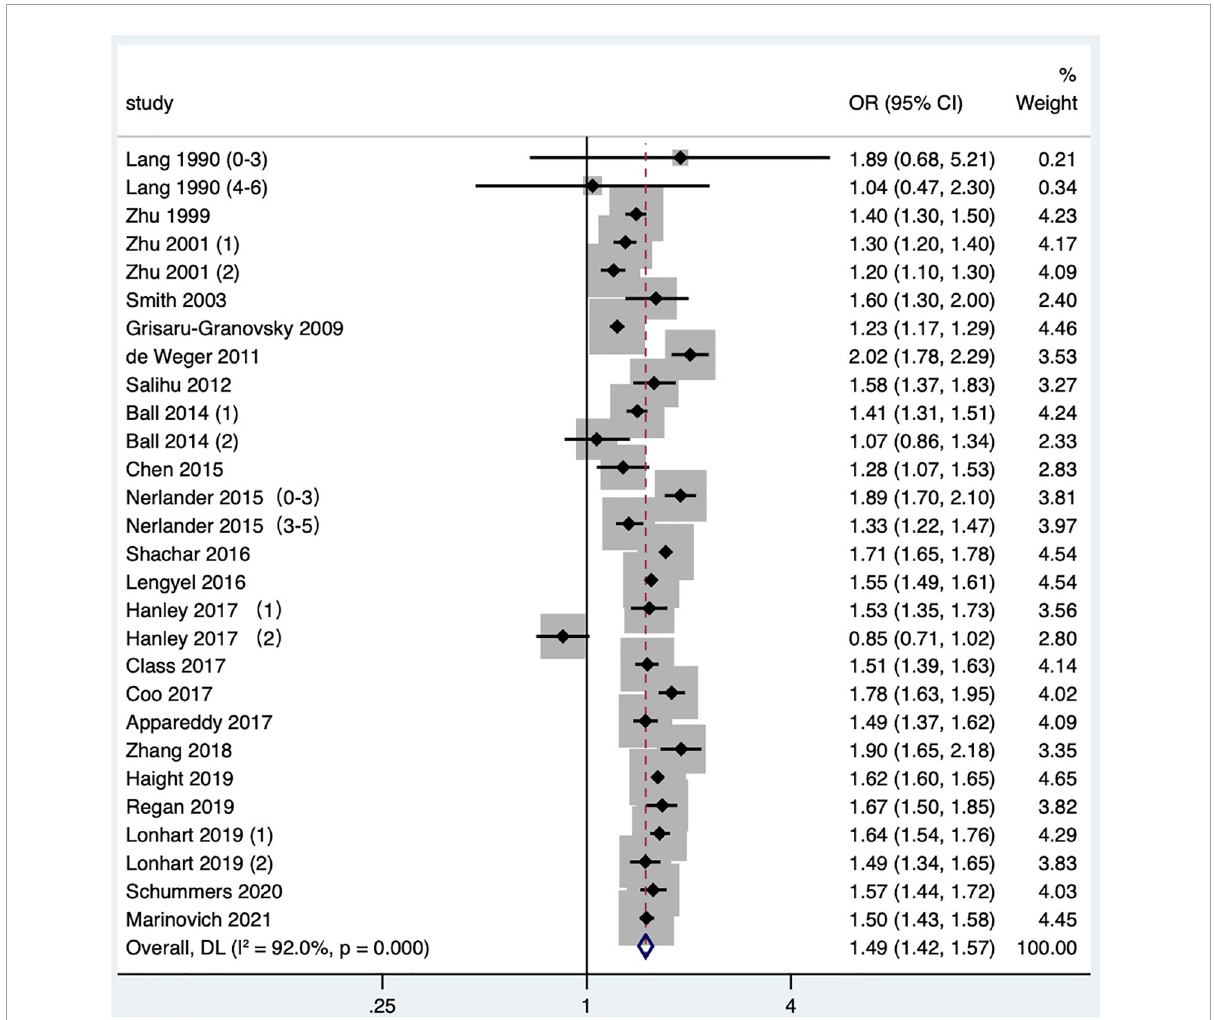
FIGURE2 Meta-analysis forest map of the effect of short IPI on preterm birth. Lang et al. (14) (0–3) referred to the IPI of 0–3 months vs. 18–23 months; Lang et al. (14) (4–6) referred to the IPI of 4–6 months vs. 18–23 months; Nerlander et al. (27) (0–3) referred to the IPI of 0–3 months vs. 18–23 months; Nerlander et al. (27) (3–5) referred to the IPI of 3–5 months vs. 18–23 months; Zhu et al. (15) (1) was white data, Zhu et al. (15) (2) was black data; Hanley et al. (36) (1) was non-matching data, and Hanley et al. (36) (2) was within-mother matching data; Ball et al. (24) (1) was non-matching data, Ball et al. (24) (2) was within-mother matching data; Lonhart et al. (43) (1) was non-Hispanic whites data, and Lonhart et al. (43) (2) was non-Hispanic blacks